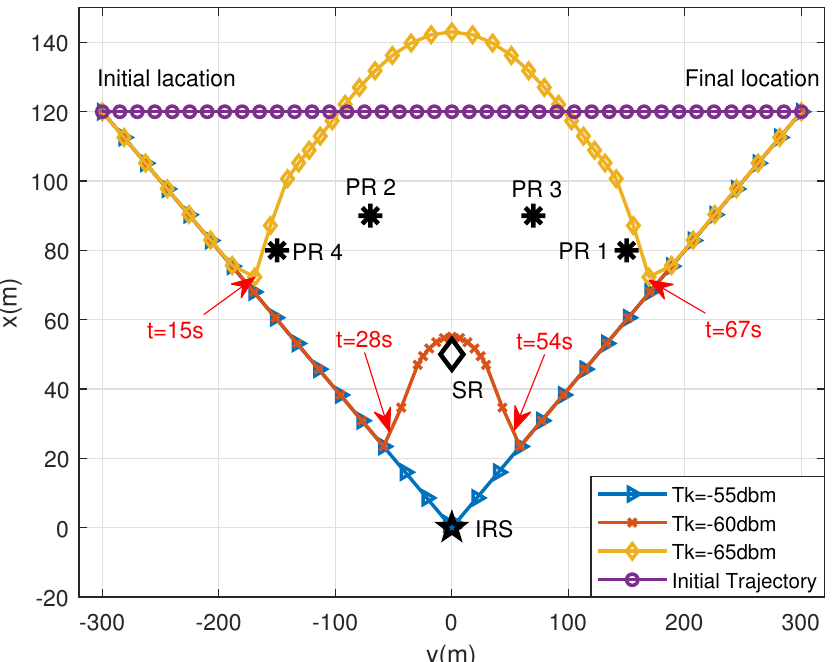
Figure 4. The UAV trajectory with different IT thresholds.